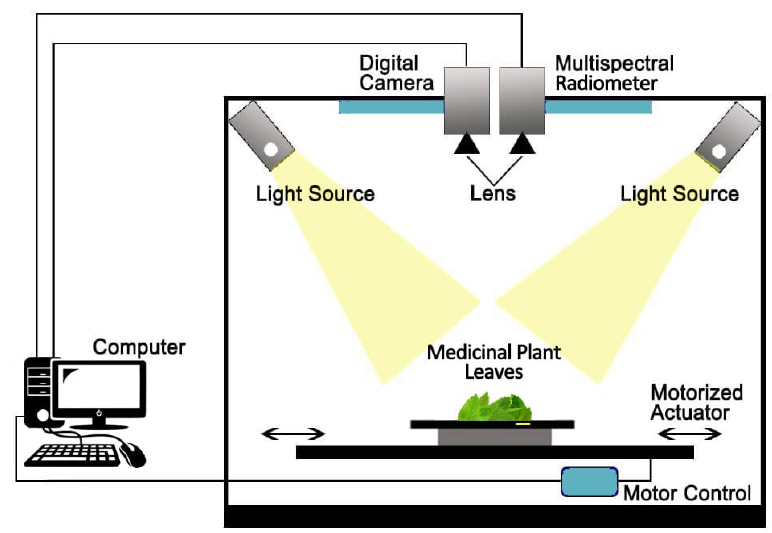
Figure 2. Computer vision laboratory setup for medicinal plant leaves image acquisition.